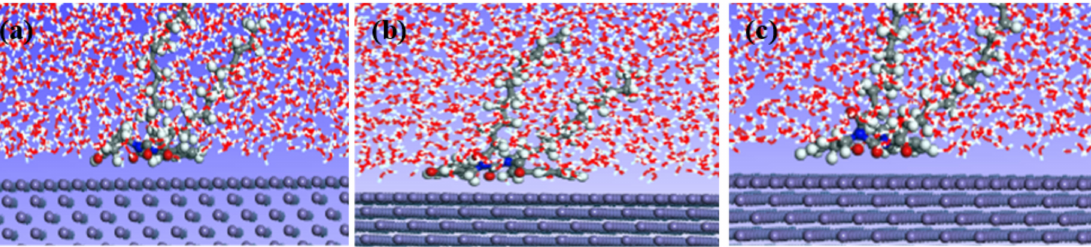
Figure 3. Adsorption behavior of corrosion inhibitor and Fe surface in different temperature systems. (( a ) 140 ◦ C, ( b ) 160 ◦ C, ( c ) 180 ◦